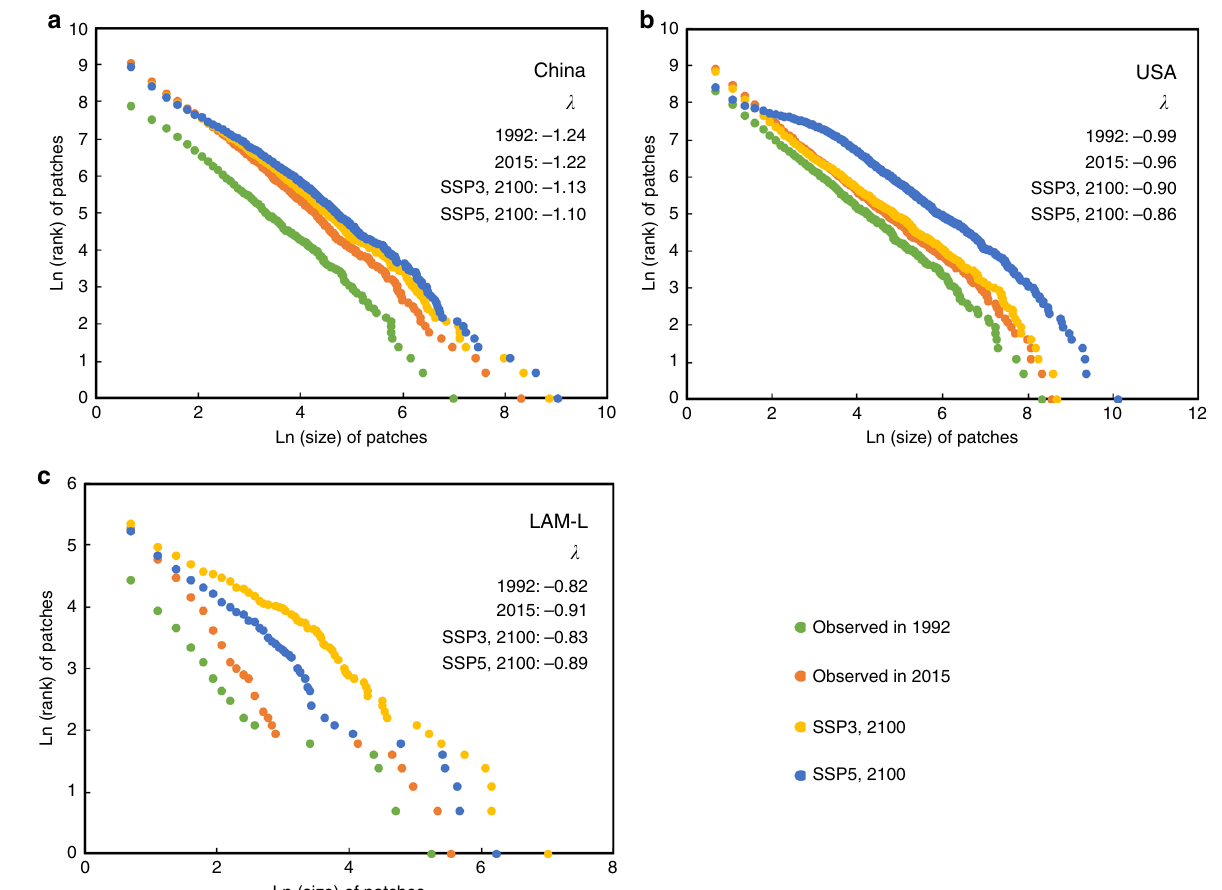
Fig. 4 The rank-size distributions of urban land patches in the representative regions in different periods. The implementation of a patch-based simulation strategy has successfully revealed the changes in urban systems in terms of the rank-size distributions of urban land patches. The LAM-L region consists of the low-income countries of Latin America, including Belize, Guatemala, Haiti, Honduras and Nicaragua.